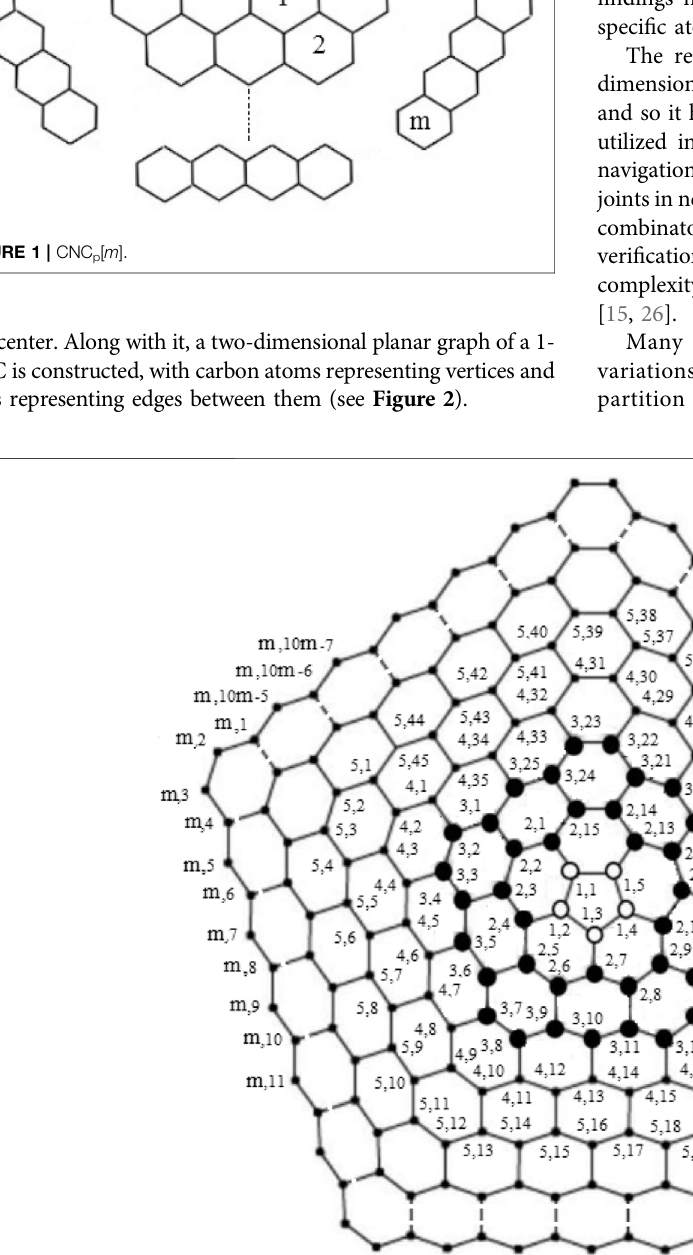
FIGURE 2 | CNC 5 [ m